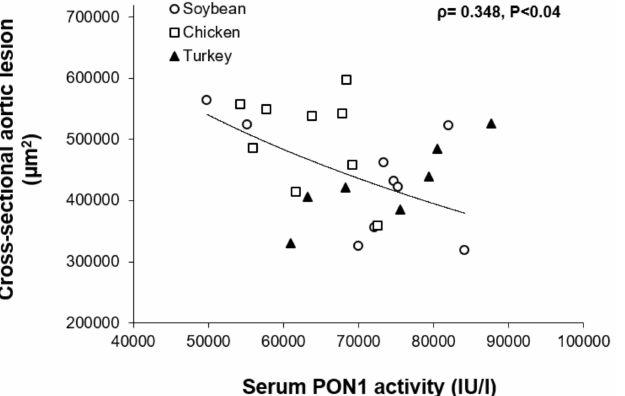
Figure 3. Relationship between serum paraoxonase activity and cross-sectional aortic lesions in female individual mice from all dietary groups. Spearman’s rank-order correlation coefficient ( ρ ) and its probability are